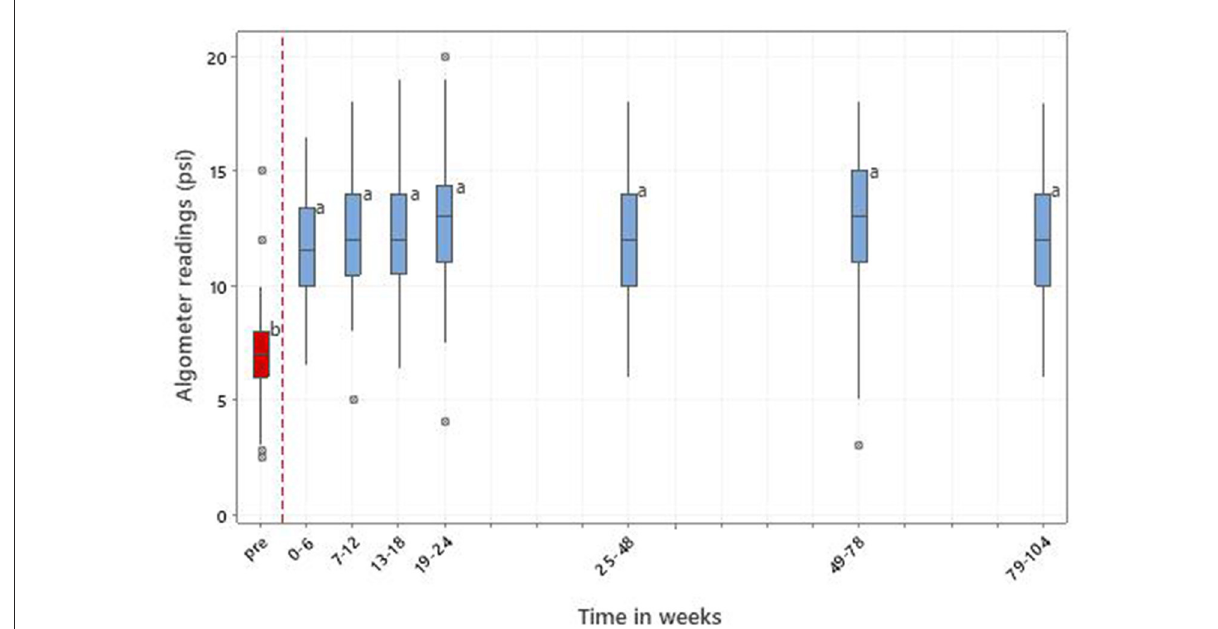
FIGURE8 Pain threshold at the lumbosacral junction in 171 dogs with LSD treated with RM in time windows representing pretreatment (pre) and up to 104 weeks post initial treatment. Letters adjacent to each bar indicate which time windows are significantly different (i.e., those not sharing a common